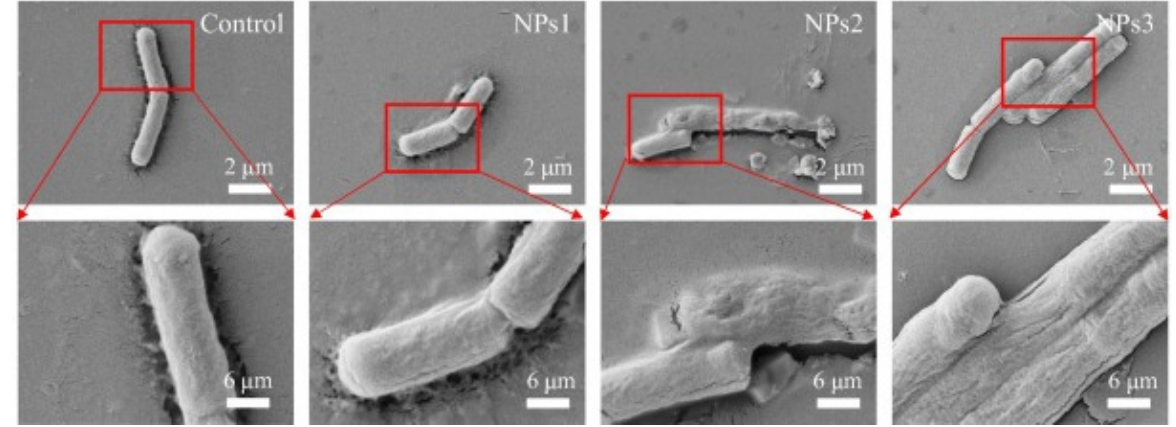
Figure 13. SEM images of B. subtilis cells without treatment and treated with 10 mg/mL GO@CS@TiO 2 for 2 h. NPs1, NPs2 and NPs3 indicates the ratio of GO/CS/TiO 2 equals to 1:20:2, 1:20:4 (the best activity), 1:20:8, respectively. Reprinted with permission from [129]. Copyright (2017) Elsevier.